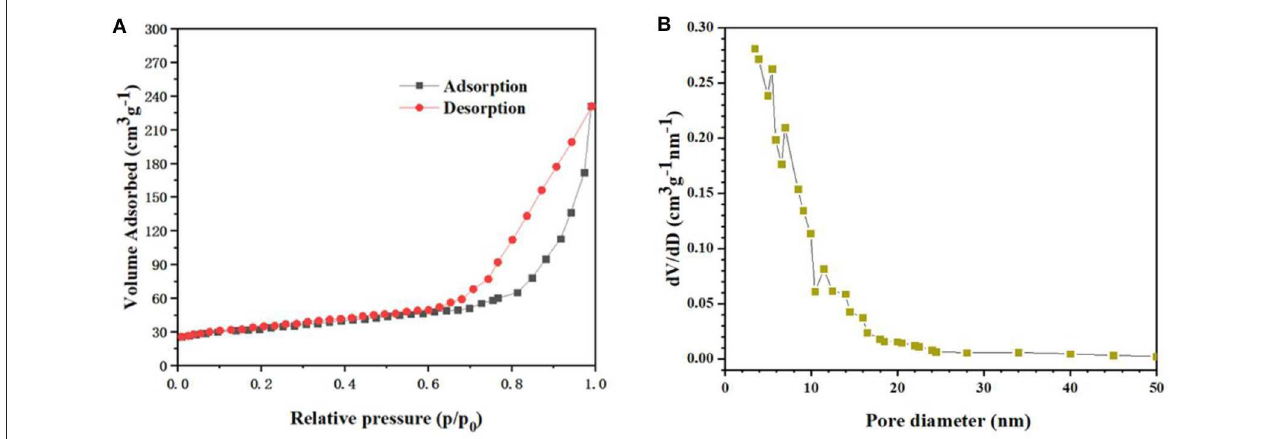
FIGURE 3 | (A) The N 2 adsorption/desorption isotherms and (B) pore size distribution of CC/TiO 2 /Fe 2 O 3 hollow nano-arrays.